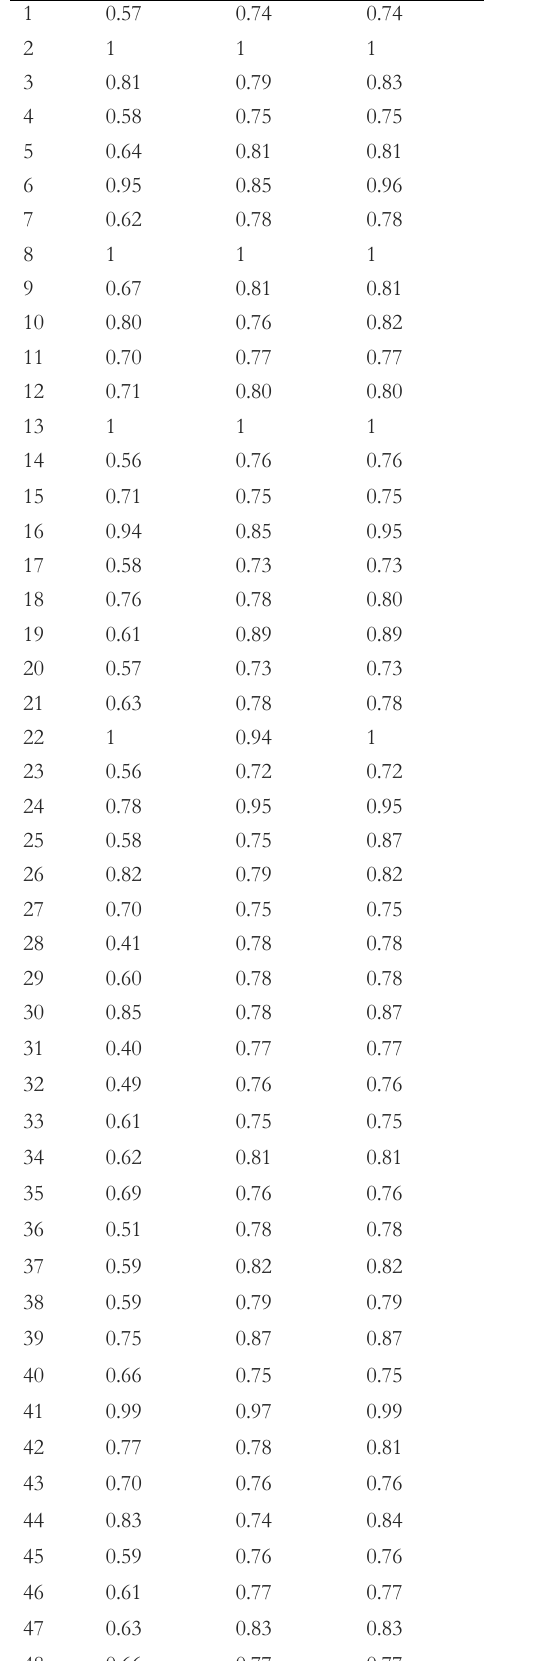
Table 1 . The results are exhibited in Table 2 . Table 2. CCR efficiency